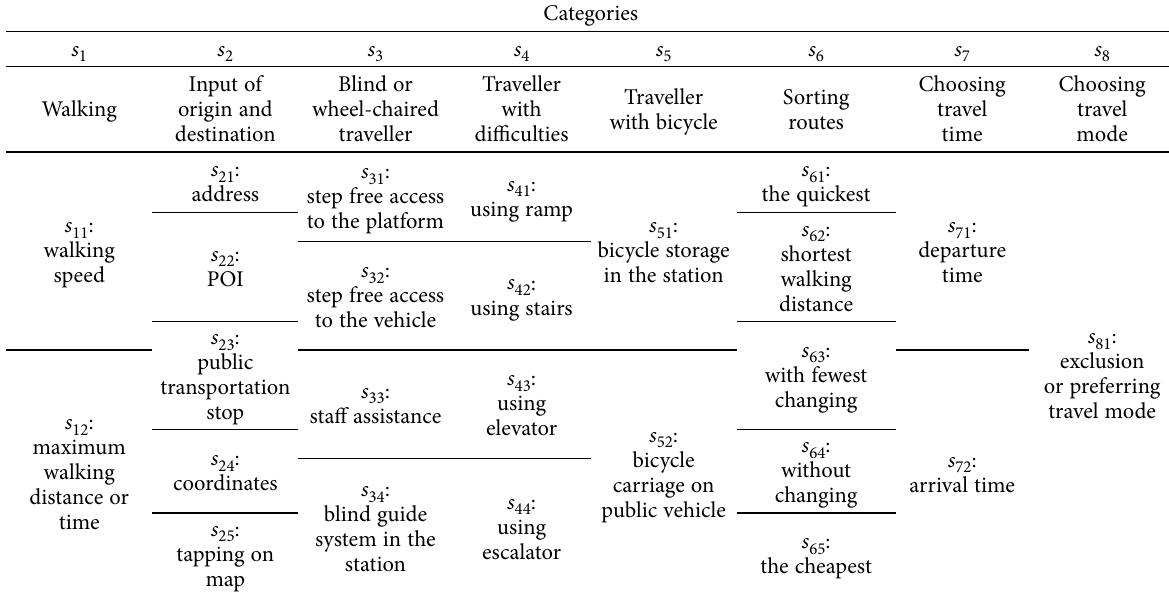
Fig. 2. Grouping of the chosen route planner applications (source: research by the authors) Table 1. Existing route planner applications’ settings and their categories (source: research by the